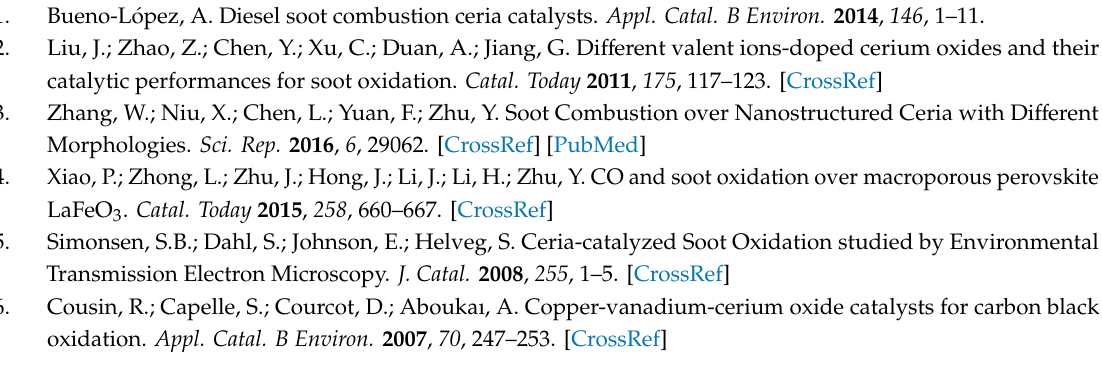
Figure S1: TGA profile of Ni-Ce-pH catalysts: (a) Ni-Ce-8, (b) Ni-Ce-9, and (c) Ni-Ce-10; Figure S2: FTIR spectra of Ni-Ce-pH catalysts before calcination: (a) Ni-Ce-8, (b) Ni-Ce-9, and (c) Ni-Ce-10; Figure S3: Ozawa plots over (a) Ni-Ce-8, (b) Ni-Ce-9, and (c) Ni-Ce-10 at di ff erent soot conversion levels (x%), with ( β ) di ff erent heating applied during the soot oxidation, and T x (temperature at ‘x%’